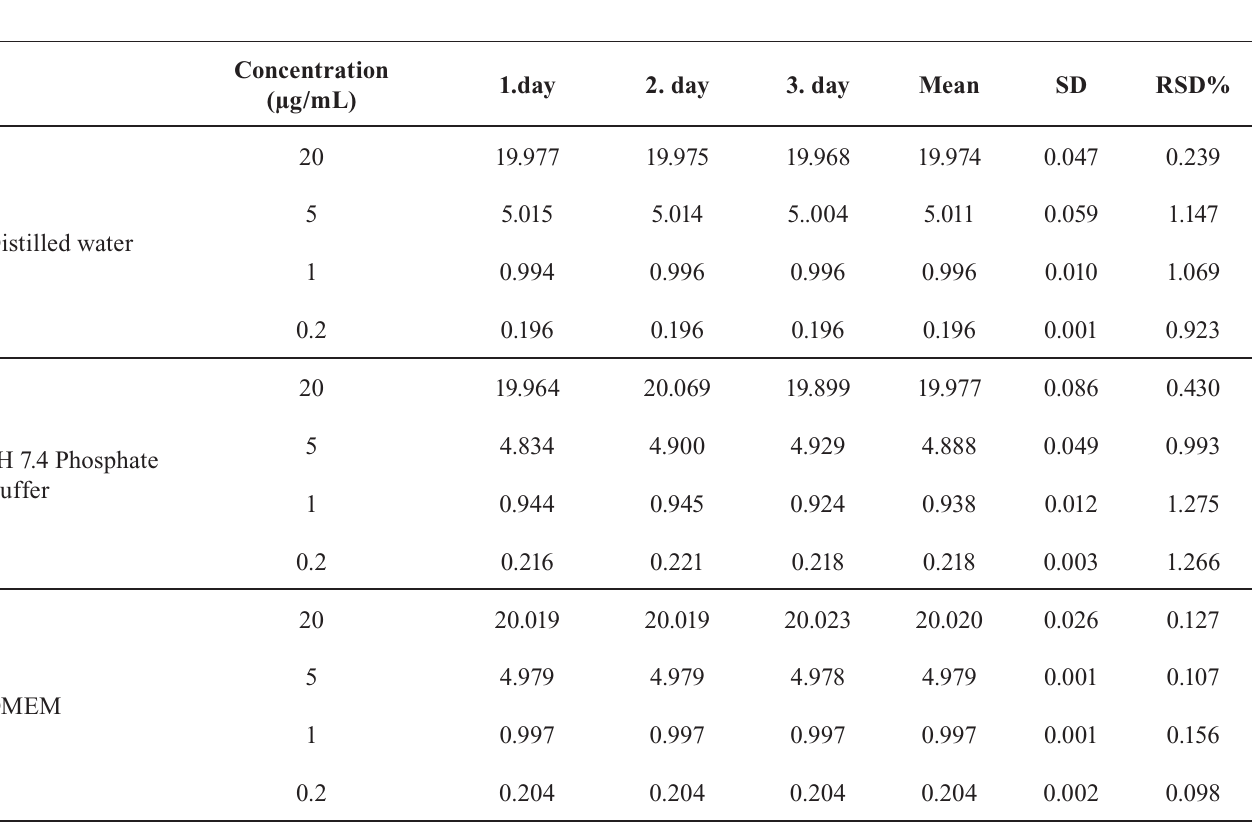
TABLE V - I nter-day precision for imatinib mesylate